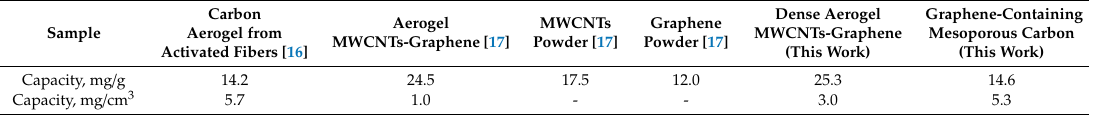
Table 6. Specific capacity of electrodes from di ff erent materials in capacitive deionization of water (CDI) and MCDI processes (Solution of NaCl = 1000 mg / dm 3 ). Carbon Sample Aerogel from Activated Fibers [16] Capacity, mg /